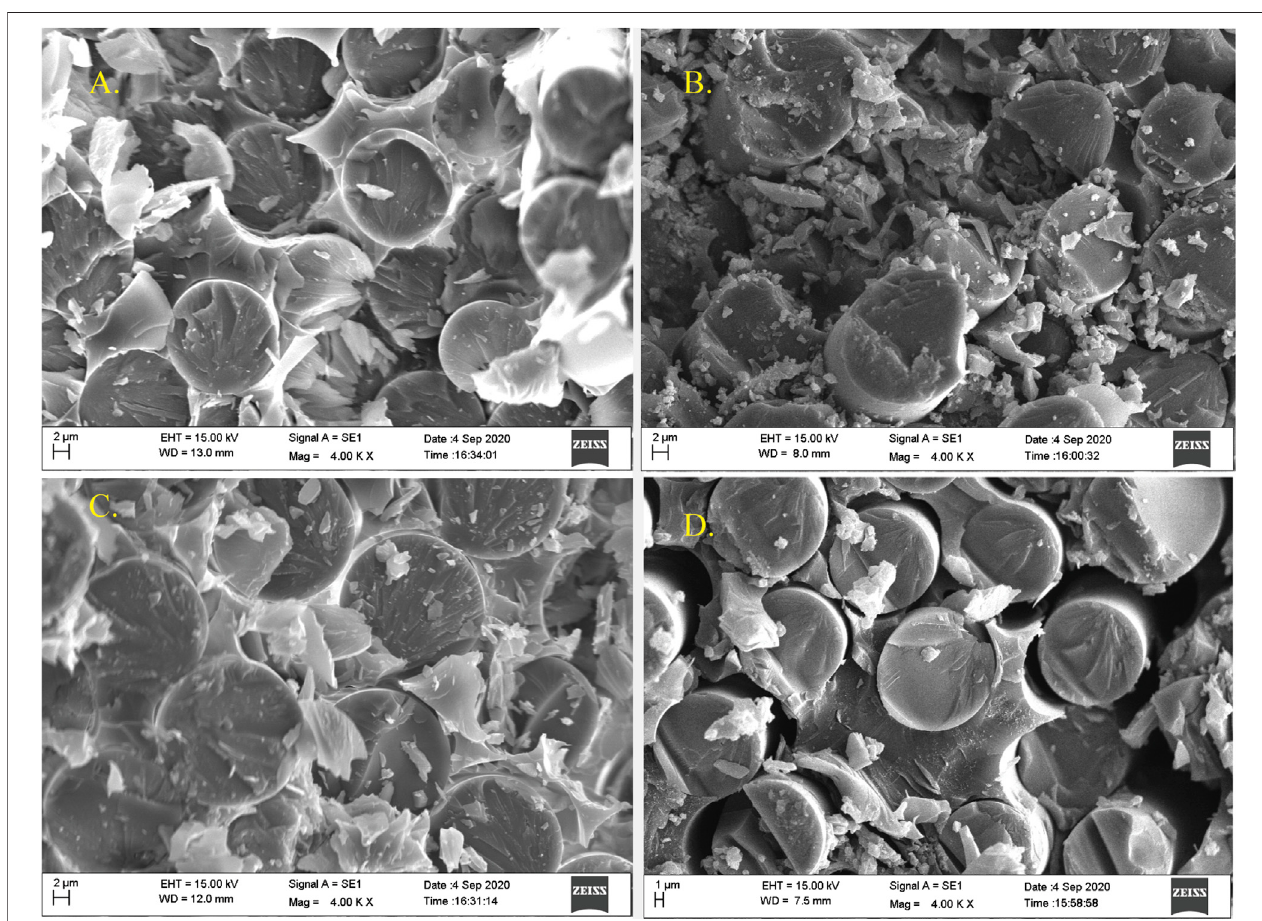
FIGURE 8 | SEM micrographs showing the interaction between the resin and the fi bers. (A) EBC, (B) MEB, (C) EGC, (D) MEG.